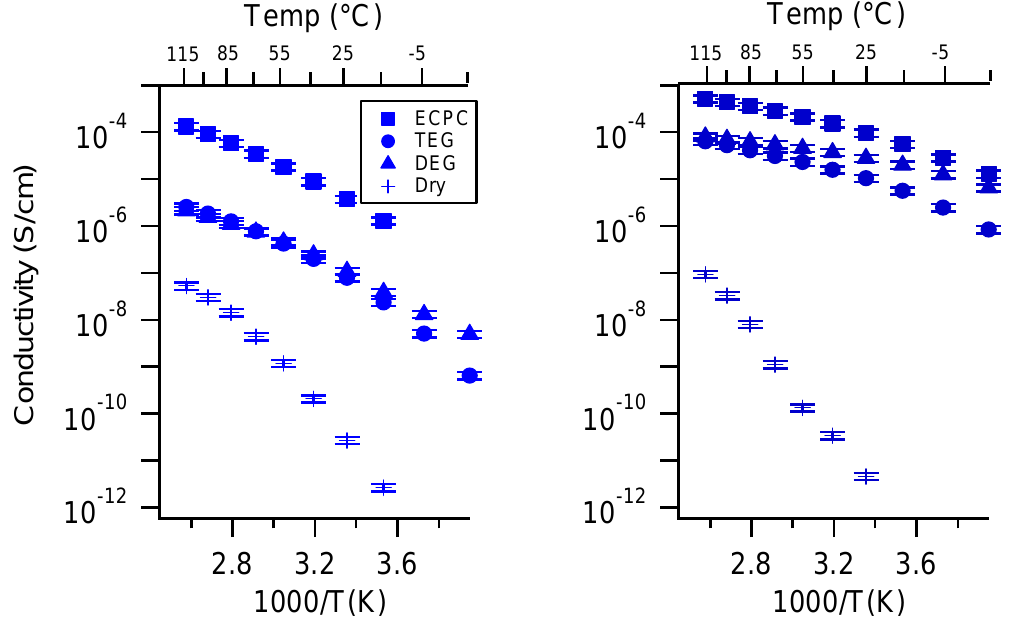
Figure A27. Conductivity as a function of solvent for PEGDMA1000_med_SSNa (left) and PTHFDA1000_med_STFSINa (right) SIPEs. Temperatures ranged from − 20 °C to 115 °C. Note that there may be a non ‐ negligible fraction of electronic conductivity in conditions where conductivity of less than 10 − 9 S/cm is reported.